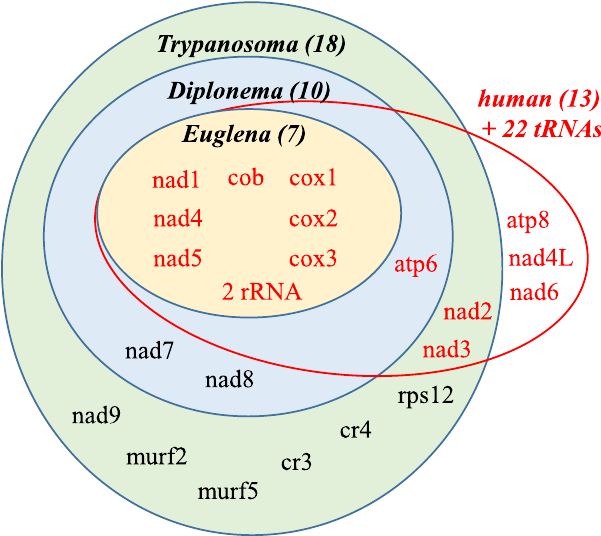
Figure 3. Schematic representation of the gene content of mitochondrial genomes of representative euglenozoans and human. The number of protein-coding genes is shown in parentheses next to selected euglenozoan flagellates. The number of protein-coding genes found in Euglena (orange oval), Diplonema (blue oval), and Trypanosoma is depicted (green oval). In comparison, human mitochondrial genome encodes 13 proteins (in red). All euglenozoans most likely contain small subunit and large subunit mito-rRNAs that in Diplonema and Euglena are likely to be highly